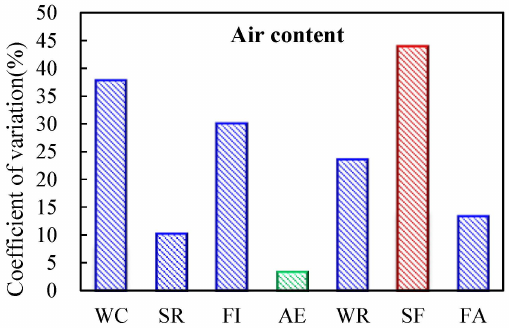
Figure 18. Difference analysis of factors on air content.